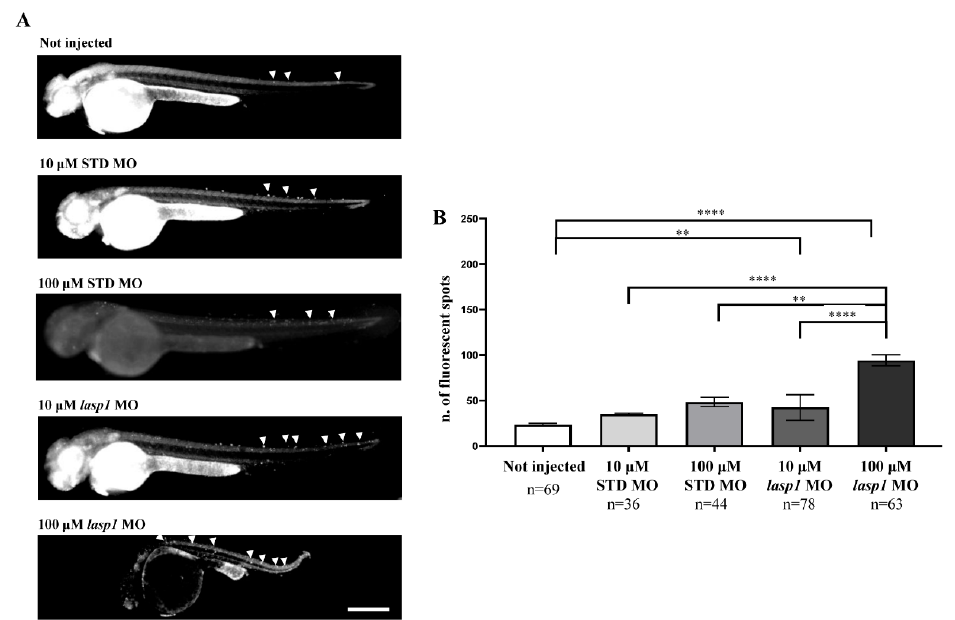
Figure 7. Injection of lasp1 MO increases apoptosis in zebrafish embryos at 48 hpf. ( A ) Representative images of acridine orange staining by fluorescence microscopy show increased apoptosis in whole embryos following injections of lasp1 MO at 10 µM and 100 µM doses. Fluorescence spots are evidenced by arrowheads. Scale bars: 200 µ m. ( B ) The acridine orange-positive spots were counted using ImageJ. Histograms represent the average numbers of fluorescent spots; error bars are SEMs. ** p < 0.01 and **** p < 0.0001 in one-way ANOVA followed by Bonferroni testing.